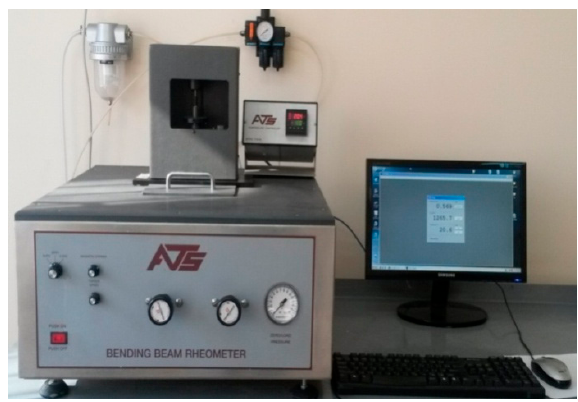
Figure 6. Rheometer with bending beam (BBR).